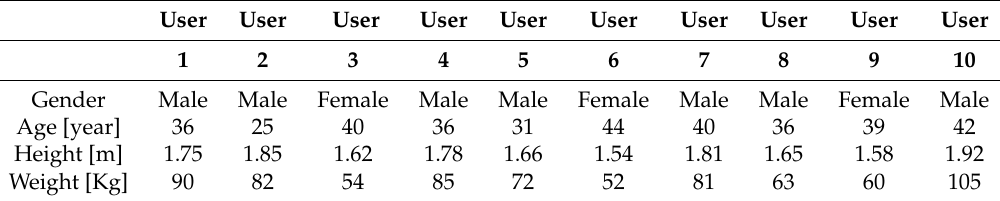
Table 1. Characteristics of the users involved in the